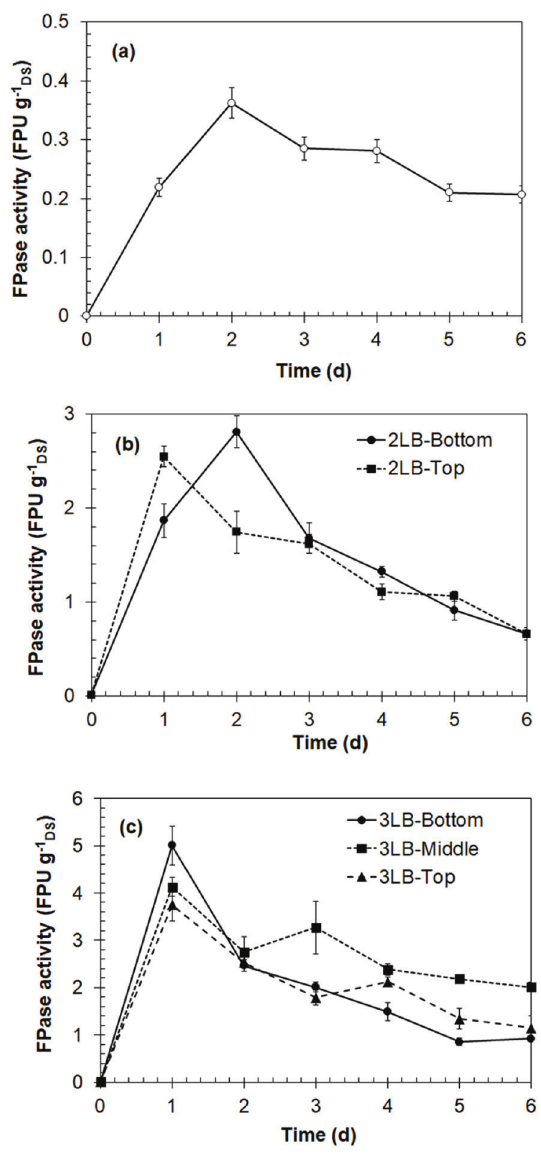
Fig. 5 – Cellulase production of A. niger in the SSF (a) Con- trol packed-bed bioreactor, cB; (b) Two-layered packed-bed bioreactor, 2lB; (c) Three-layered packed-bed bioreactor,